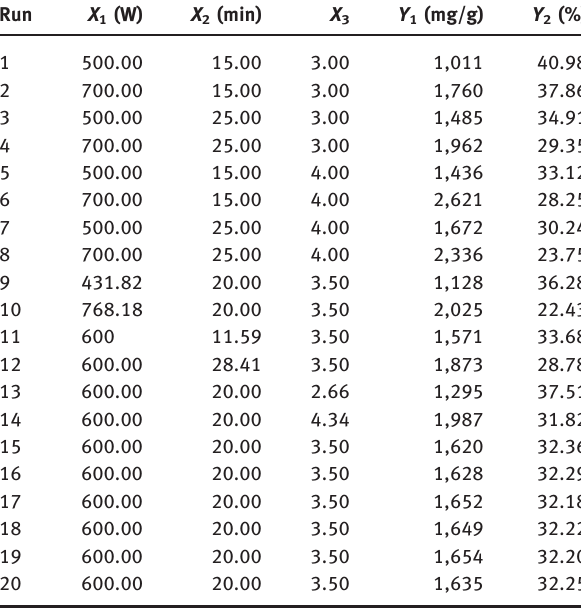
Table 2: Experimental design matrix and